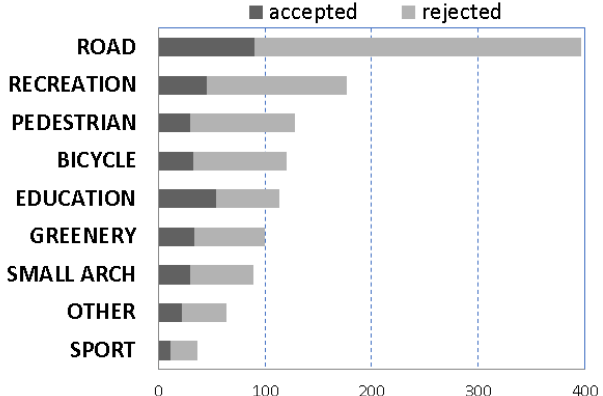
Figure 4. The types of hard projects, accepted or rejected in municipal districts through voting procedures, in Częstochowa PB in the years 2015–2019. Data were sorted by the decreasing number of projects submitted to voting procedures. Accepted projects—projects that won the vote, accepted to implementation; rejected projects—projects that did not win the vote. Acronyms are explained in methodology (Section 3.3). Source: the authors’ compilation based on the data from Częstochowa City Hall.